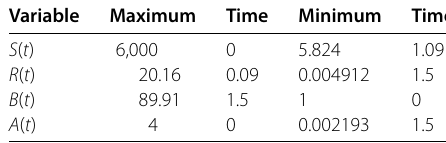
Table 2 Extremum values obtained for the variables Variable Maximum Time